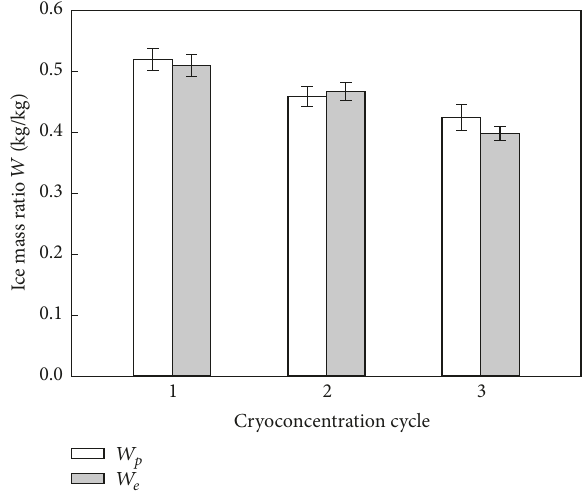
Figure 5: Experimental ( 𝑊 𝑒 ) and predicted ( 𝑊 𝑝 ) ice mass ratios as a function of cryoconcentration